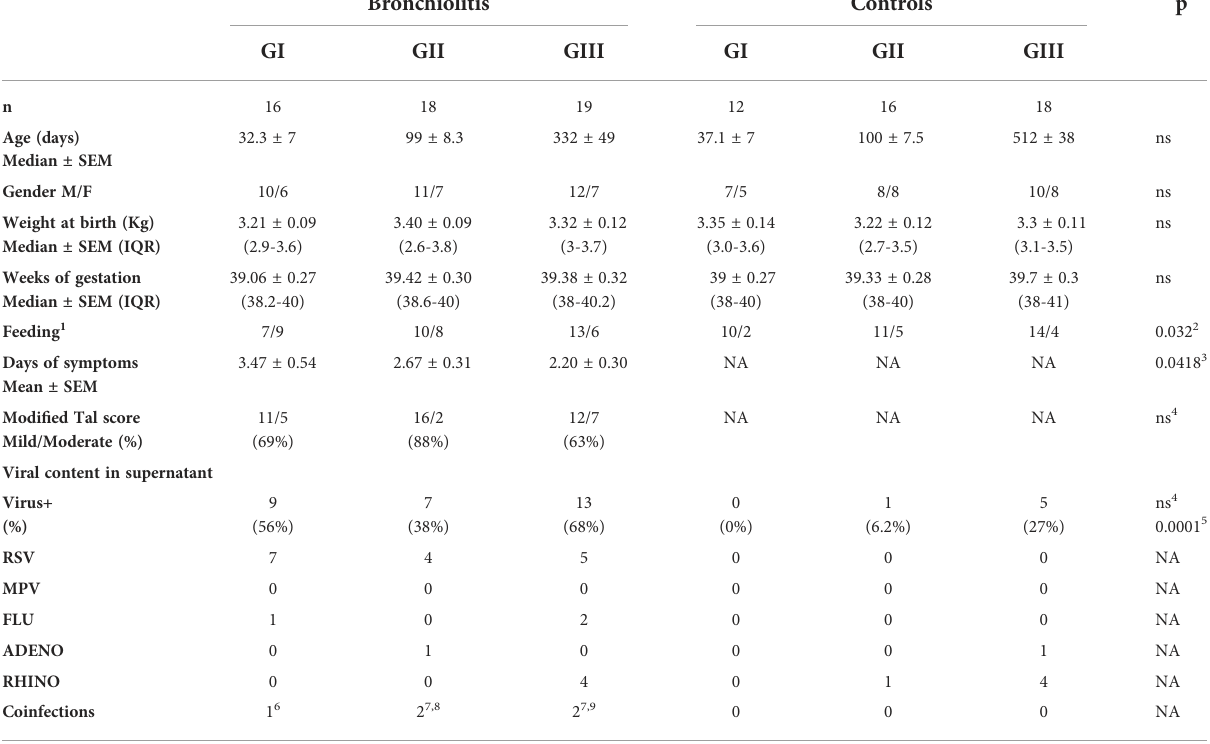
TABLE 1 Clinical data. Bronchiolitis Controls p GI GII GIII GI GII